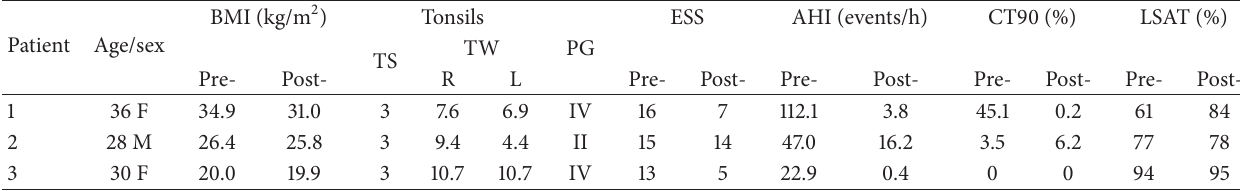
Table 1: Physiologic and polysomnographic variables before and after uvulopalatopharyngoplasty.